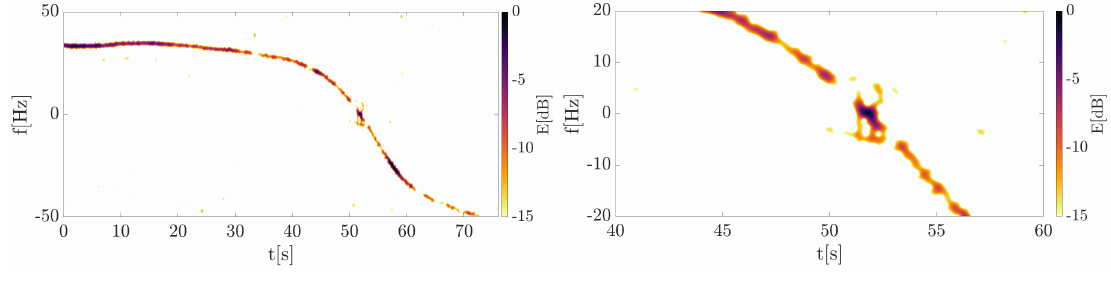
Figure 7. The energy distributions of the measured signal obtained using the classical STFT.